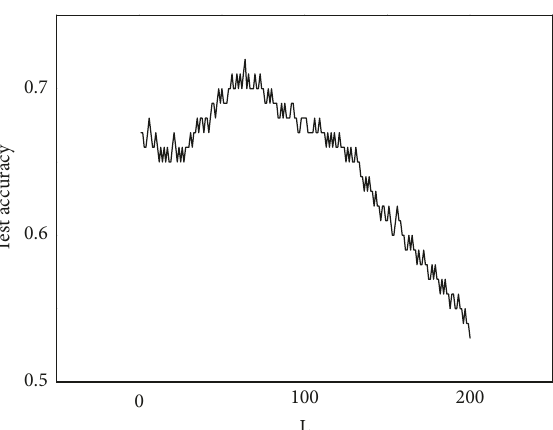
Figure 4: Comparison of recall-precision.